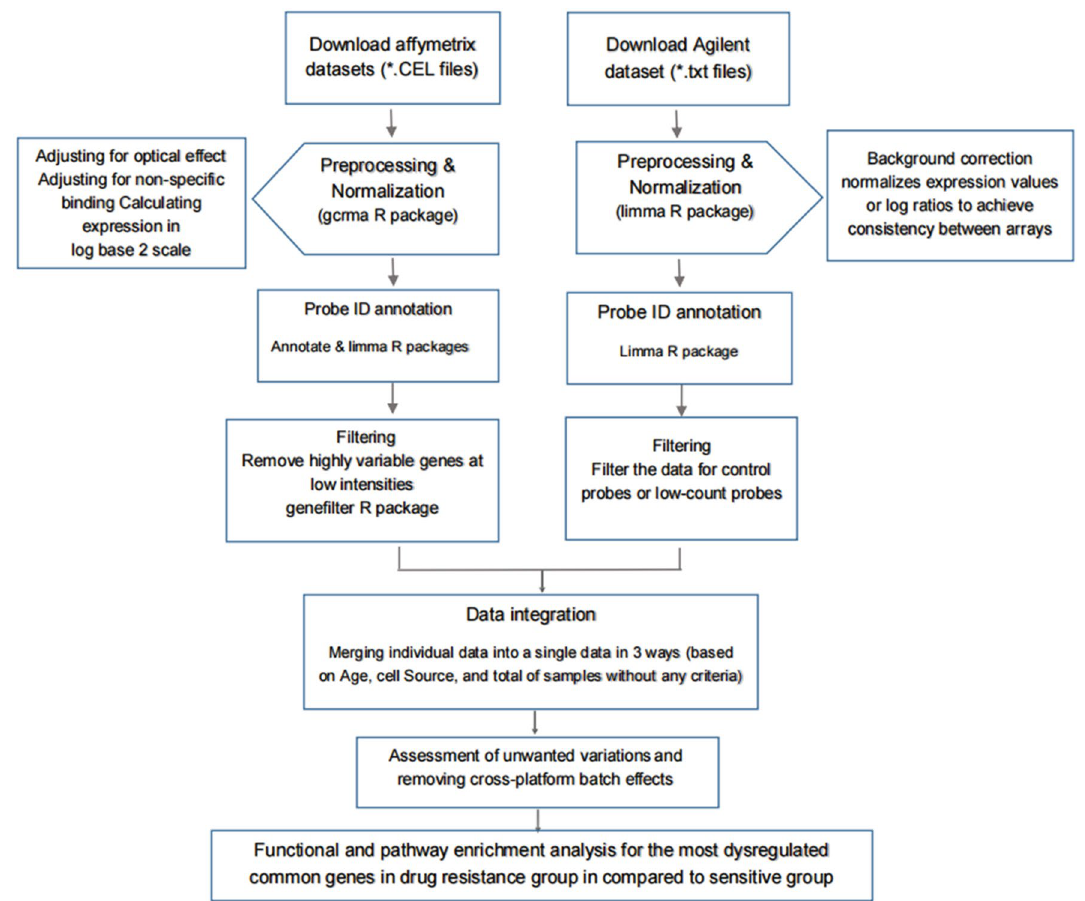
Figure 9. Workflow of conducting meta-analysis of microarray